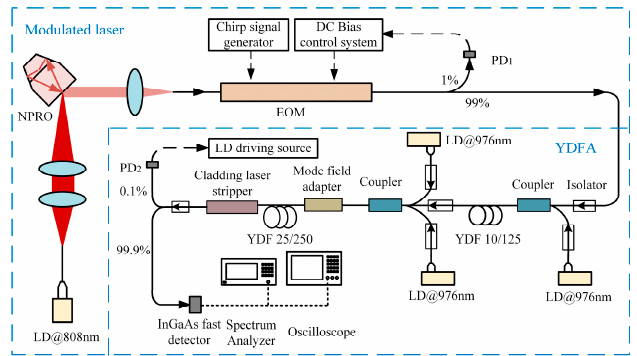
Figure 2. Diagram of the experimental setup of the chirped intensity-modulated laser and the fiber power amplifier.